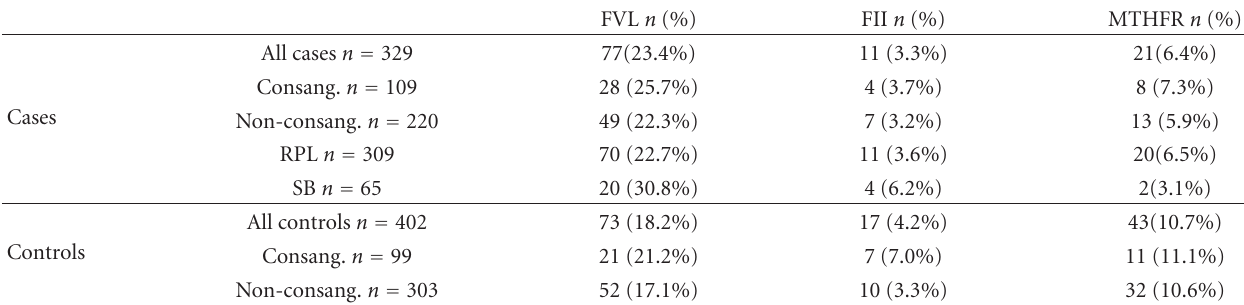
Table 2: Number and prevalence of FVL, FII, and MTHFR in the cases and normal